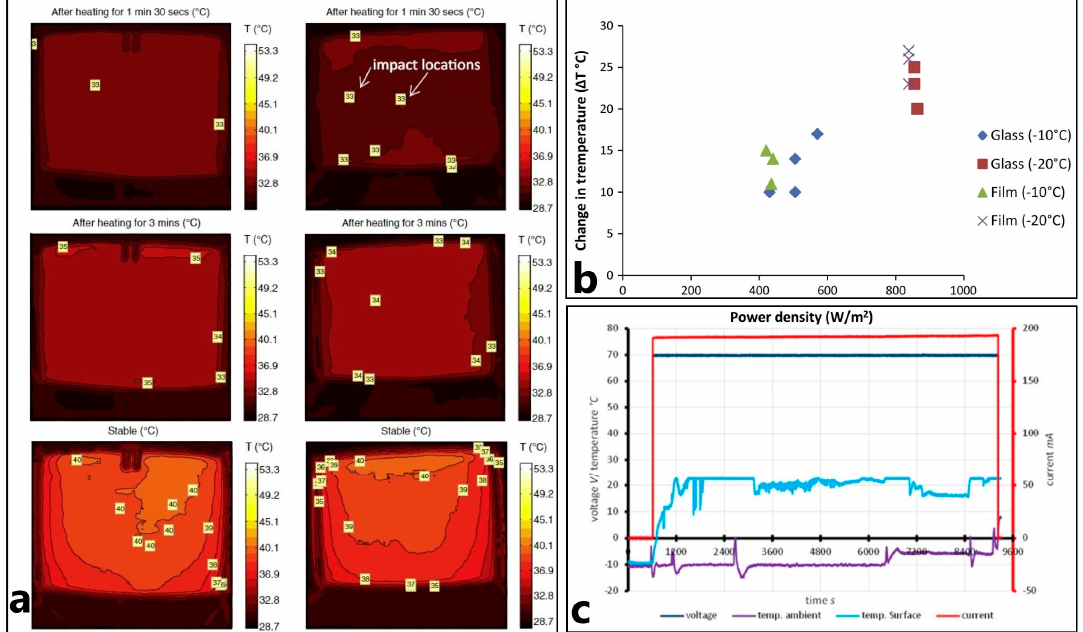
Figure 5. ( a ) Thermal imaging before and after impact on ECT panel, ( b ) change in temperature as a function of power density for anti-icing studies (reprinted with permission from Elsevier, copyright 2015) [55], and ( c ) de-icing test graph at − 5 °C and wind speed of 7 m/s (Reprinted with permission from John Wiley and Sons, copyright 2017) [57].